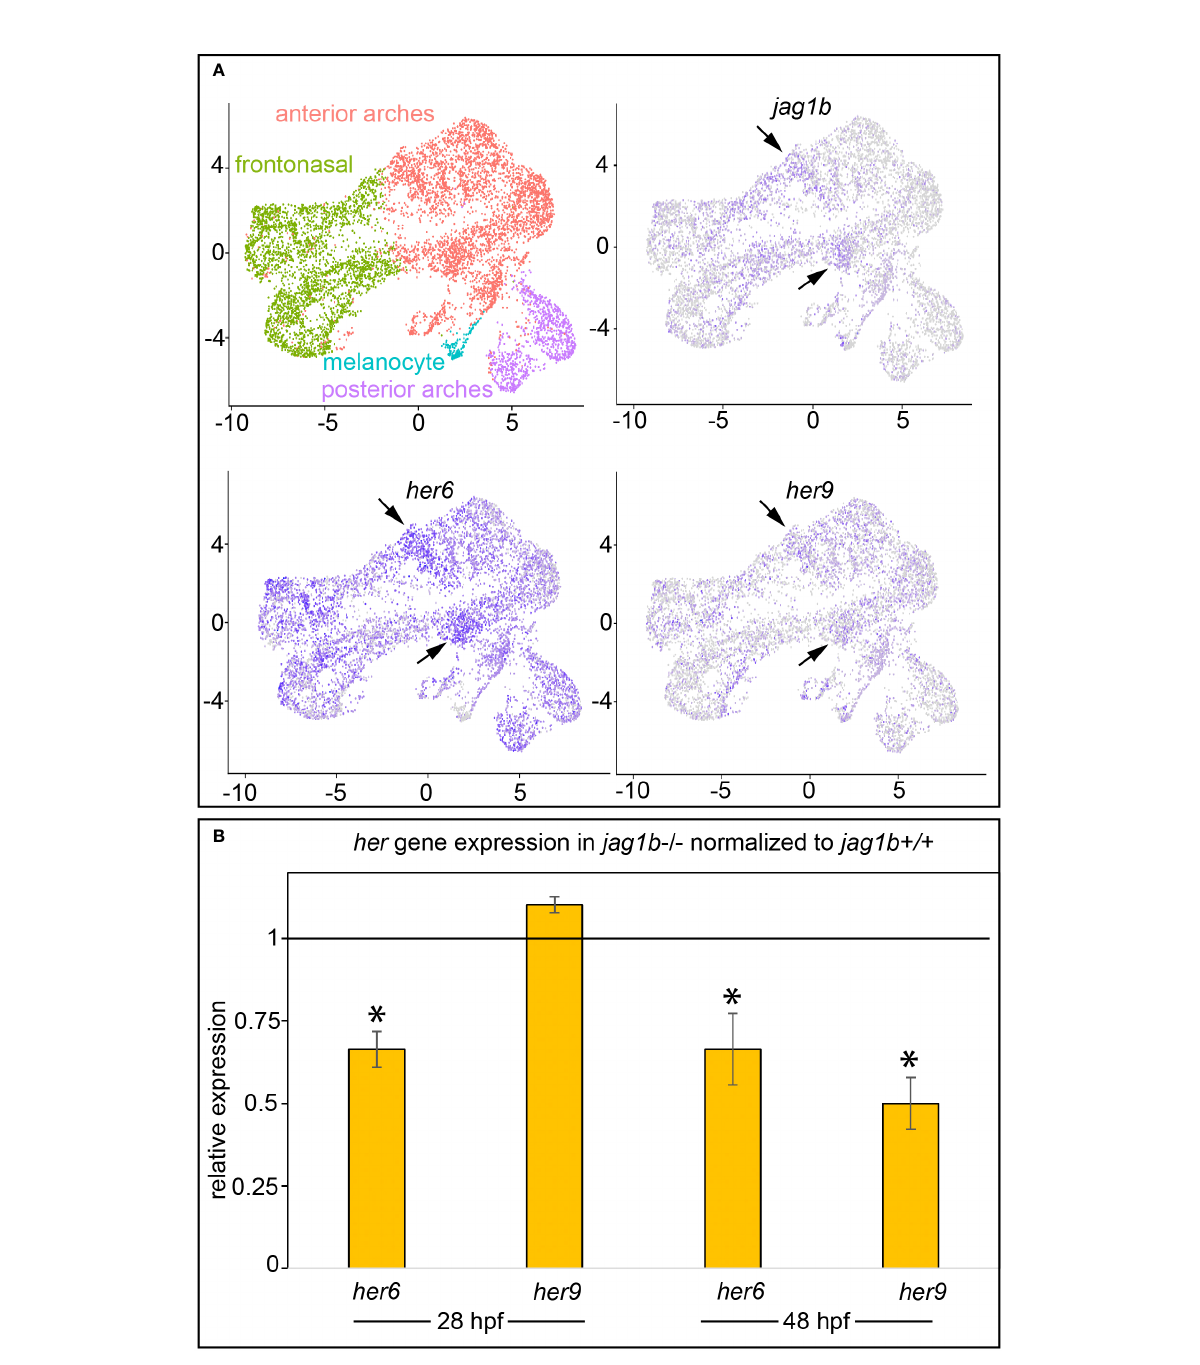
FIGURE 1 her6 and her9 are expressed in the same subpopulation of cranial neural crest cells as jag1b , and their expression is dependent upon jag1b function. (A) UMAPs from single cell RNA-sequencing on 24 hpf sorted cranial neural crest cells. As in our previous work (29), cranial neural crest cells can be clustered into four distinct populations. Based on our previous study and the landmark genes enriched in each population we can identify where the cells reside in the intact animal. Arrows indicate jag1b enrichment in a subset of anterior arch cells. Although her6 is broader, arrows indicate that some of the strongest expressing cells are the jag1b enriched populations. her9 is also broadly expressed among cranial neural crest cells, but at lower levels than her6 . Arrows indicate her9 enrichment in the jag1b ; her6 expressing populations. (B) We performed qPCR on 28 and 48 hpf genotyped heads from wild type and jag1b homozygous mutant siblings. Expression of each her gene was normalized to rps18 , then normalized to the relevant wild-type control. Reactions were performed in technical triplicate and the results represent three to six biological replicates. Each biological replicate was pooled heads from 5 – 6 genotyped homozygous wild types or homozygous mutants. Error bars are standard deviation. Asterisks indicate signi fi cant differences from wild type controls at p < 0.05 by students